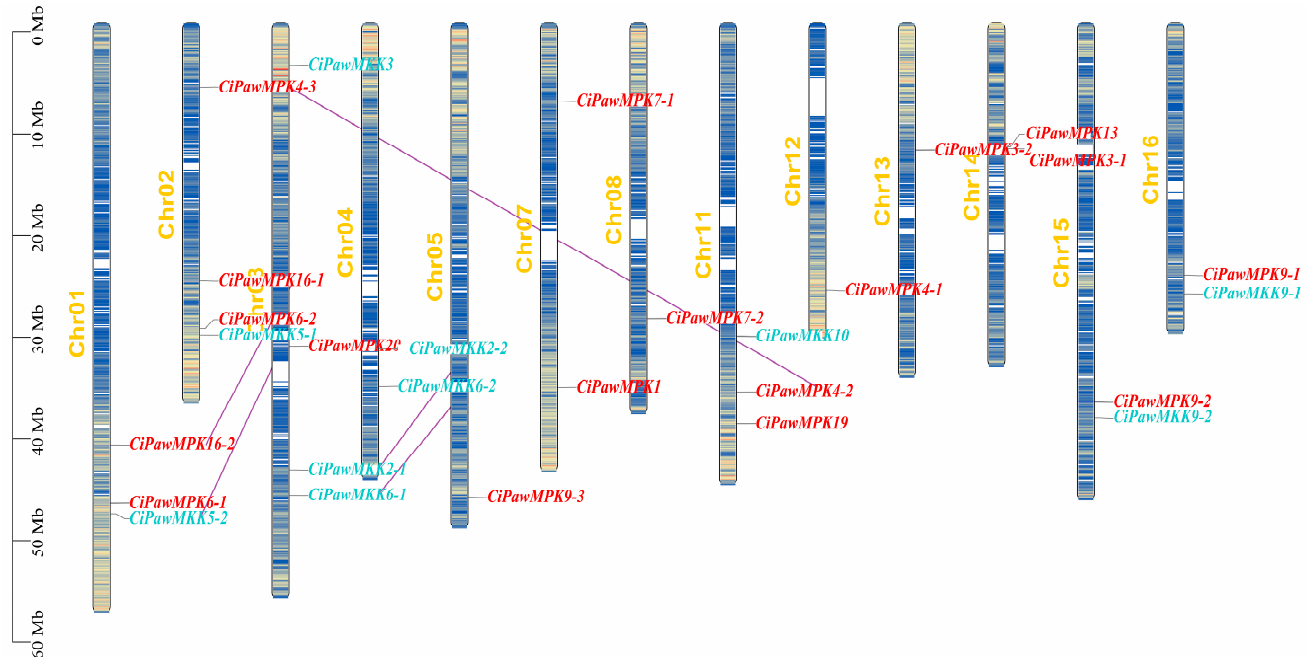
Figure 5. Distribution of MPK and MKK genes on pecan chromosomes. MPK is marked in red font, MKK genes are marked in light blue font, and pairs with interacting genes are connected by purple lines. The dense lines on each single chromosome show the distribution of all genes on this chromo- some.